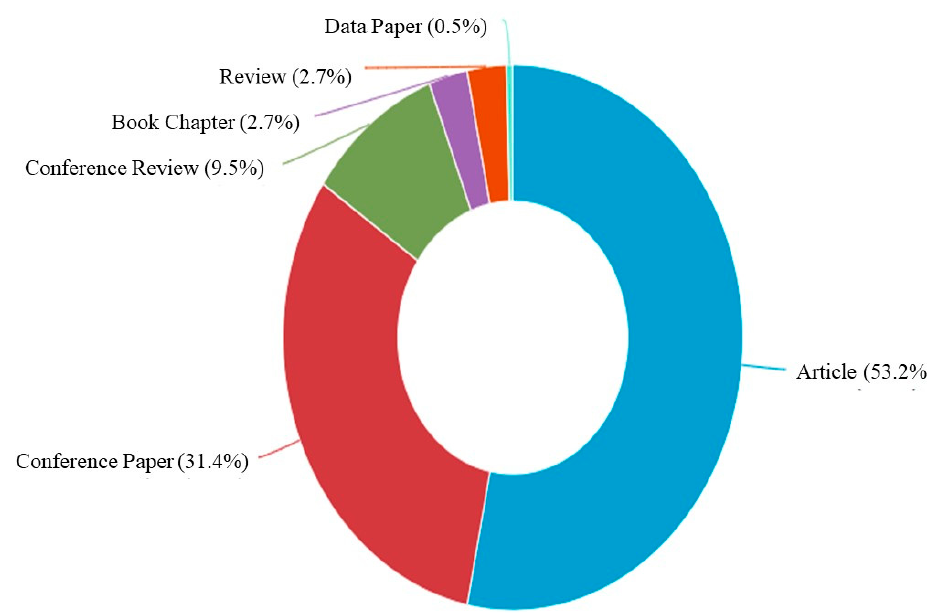
Figure 5. Various types of documents published in the related study field.